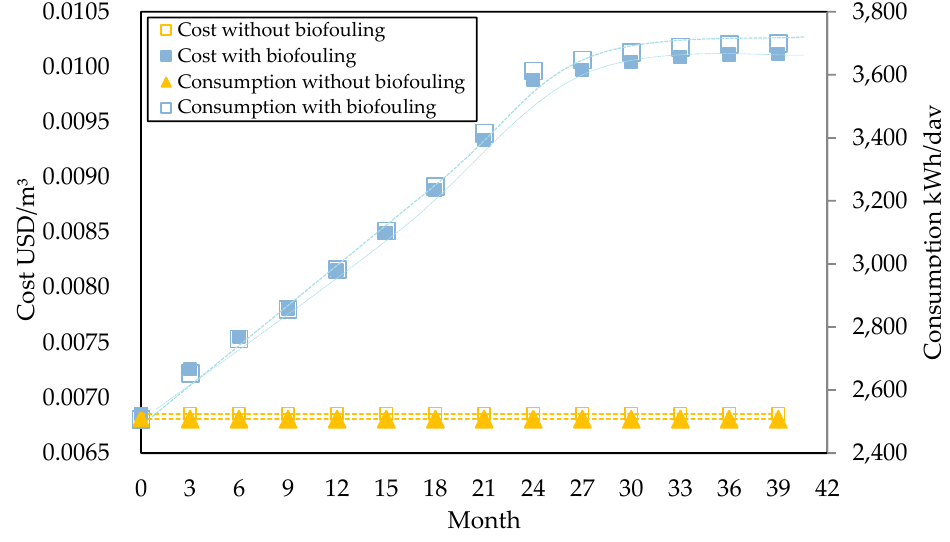
Figure 9. Daily consumption, in kilowatt hours per day (kWh/day), and cost of pumping, in dollars per cubic meter (USD/m³), for the Elevated Pumping Station of Rio Branco, including both a pumping system with and without golden mussel bioinfestation.